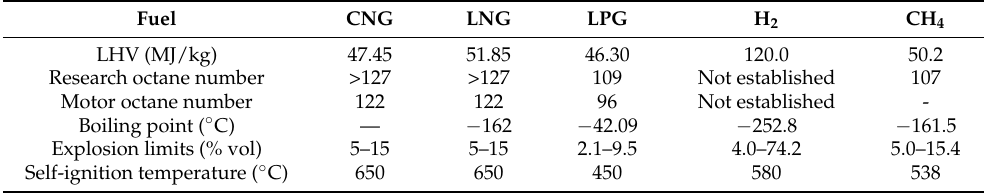
Table 3. Comparison of properties of different alternative gaseous fuels